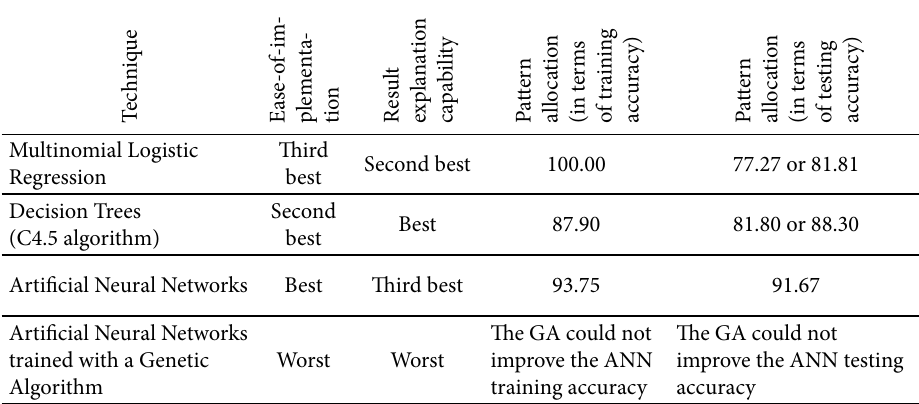
u q n i h c T e Not Not possible Worst C-Means Best possible Objective: automatic characterization Fuzzy C-Means Second Best Possible of the clusters based on the linguistic terms. Subjective: based on the individual Self-Organising Worst. Highly Not feature planes, the distances between Maps parametrized. possible neurons and analyst interpretation. Objective: automatic characterization of the clusters based on the linguistic terms. A more robust linguistic Modified Fuzzy Third best Possible characterization than Fuzzy C-Means C-Means: based only on the certain observations. Table 5. The comparison of different classification techniques for assessing NFIs’ financial performance